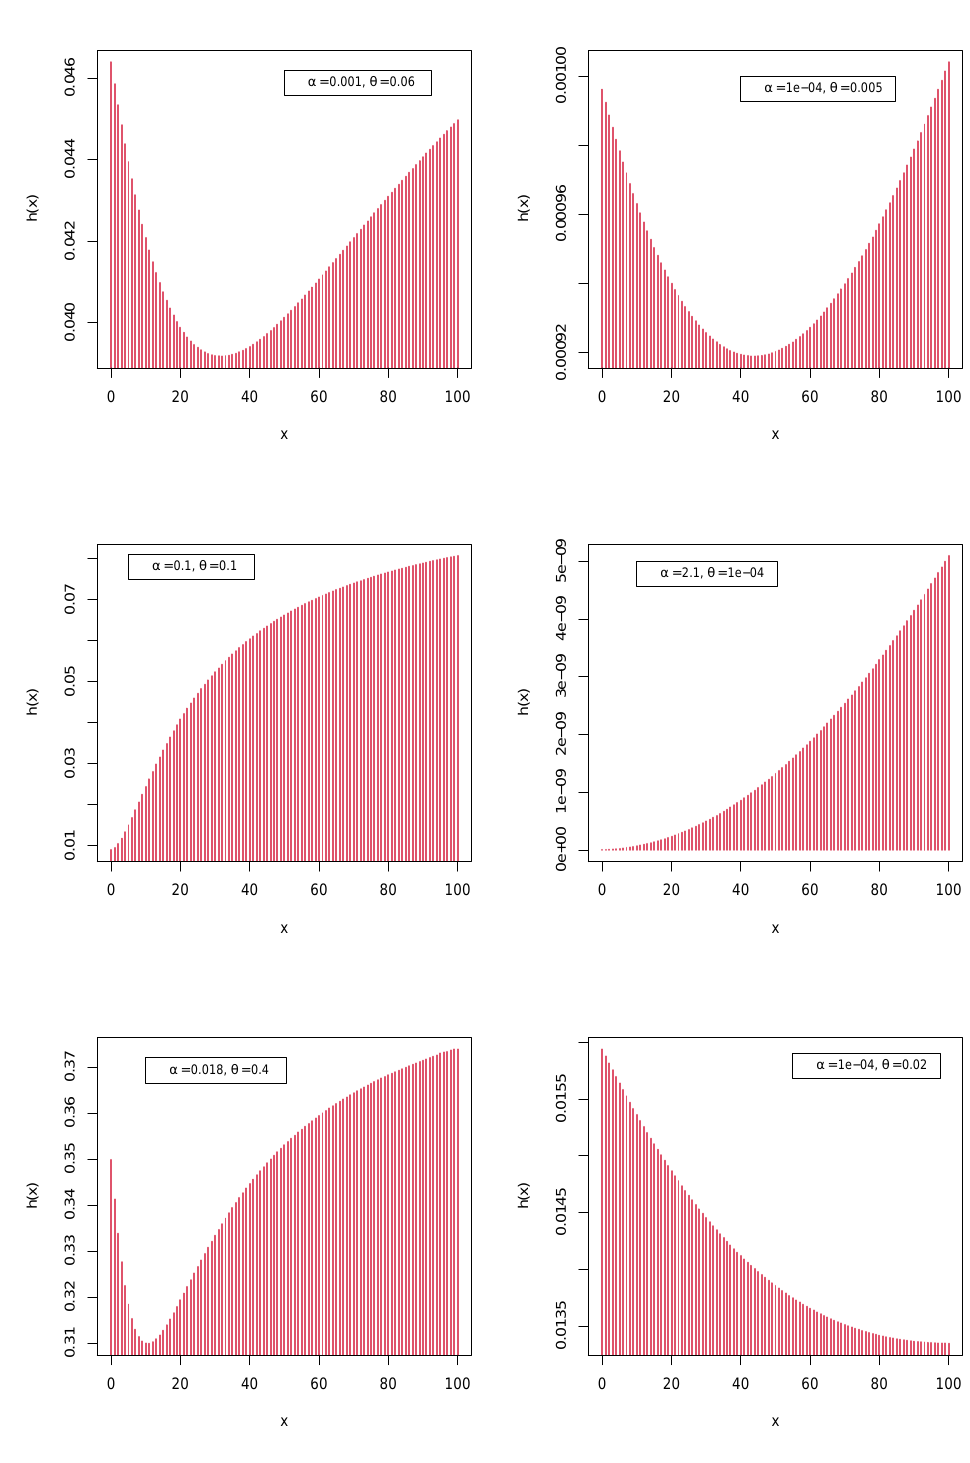
Figure 3. Plots of the hf of the